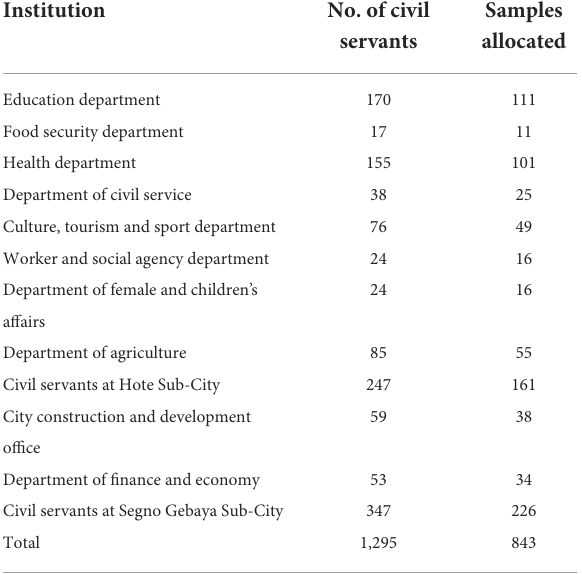
TABLE 2 The sampling procedure among governmental institutions in DCA,